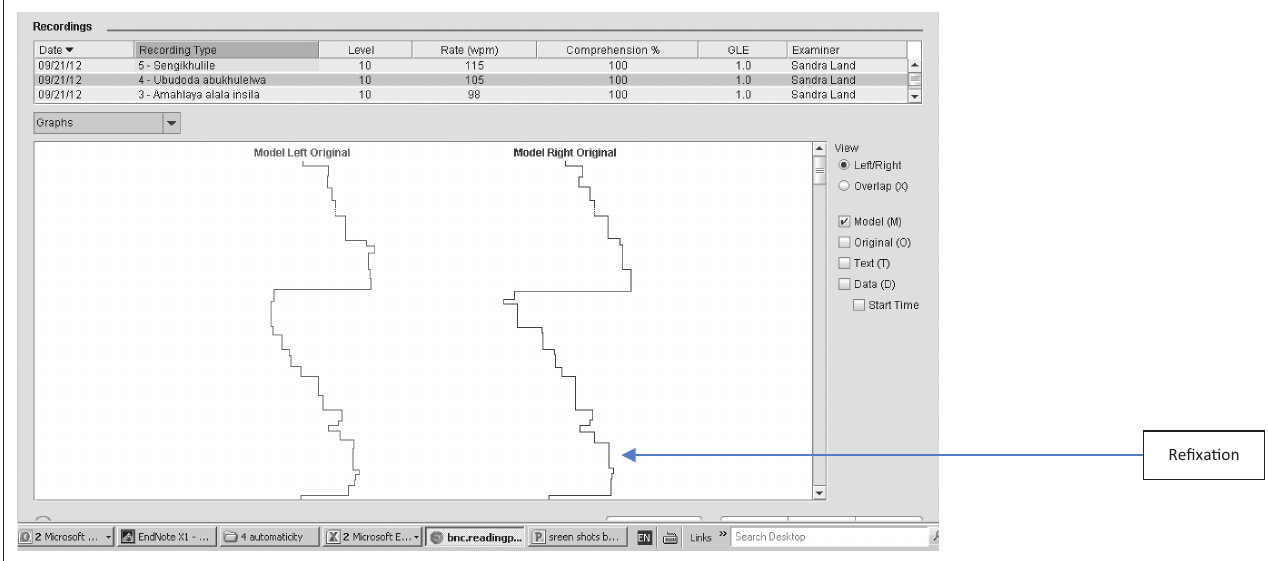
FIGURE 2: Eye movements of a reader with many